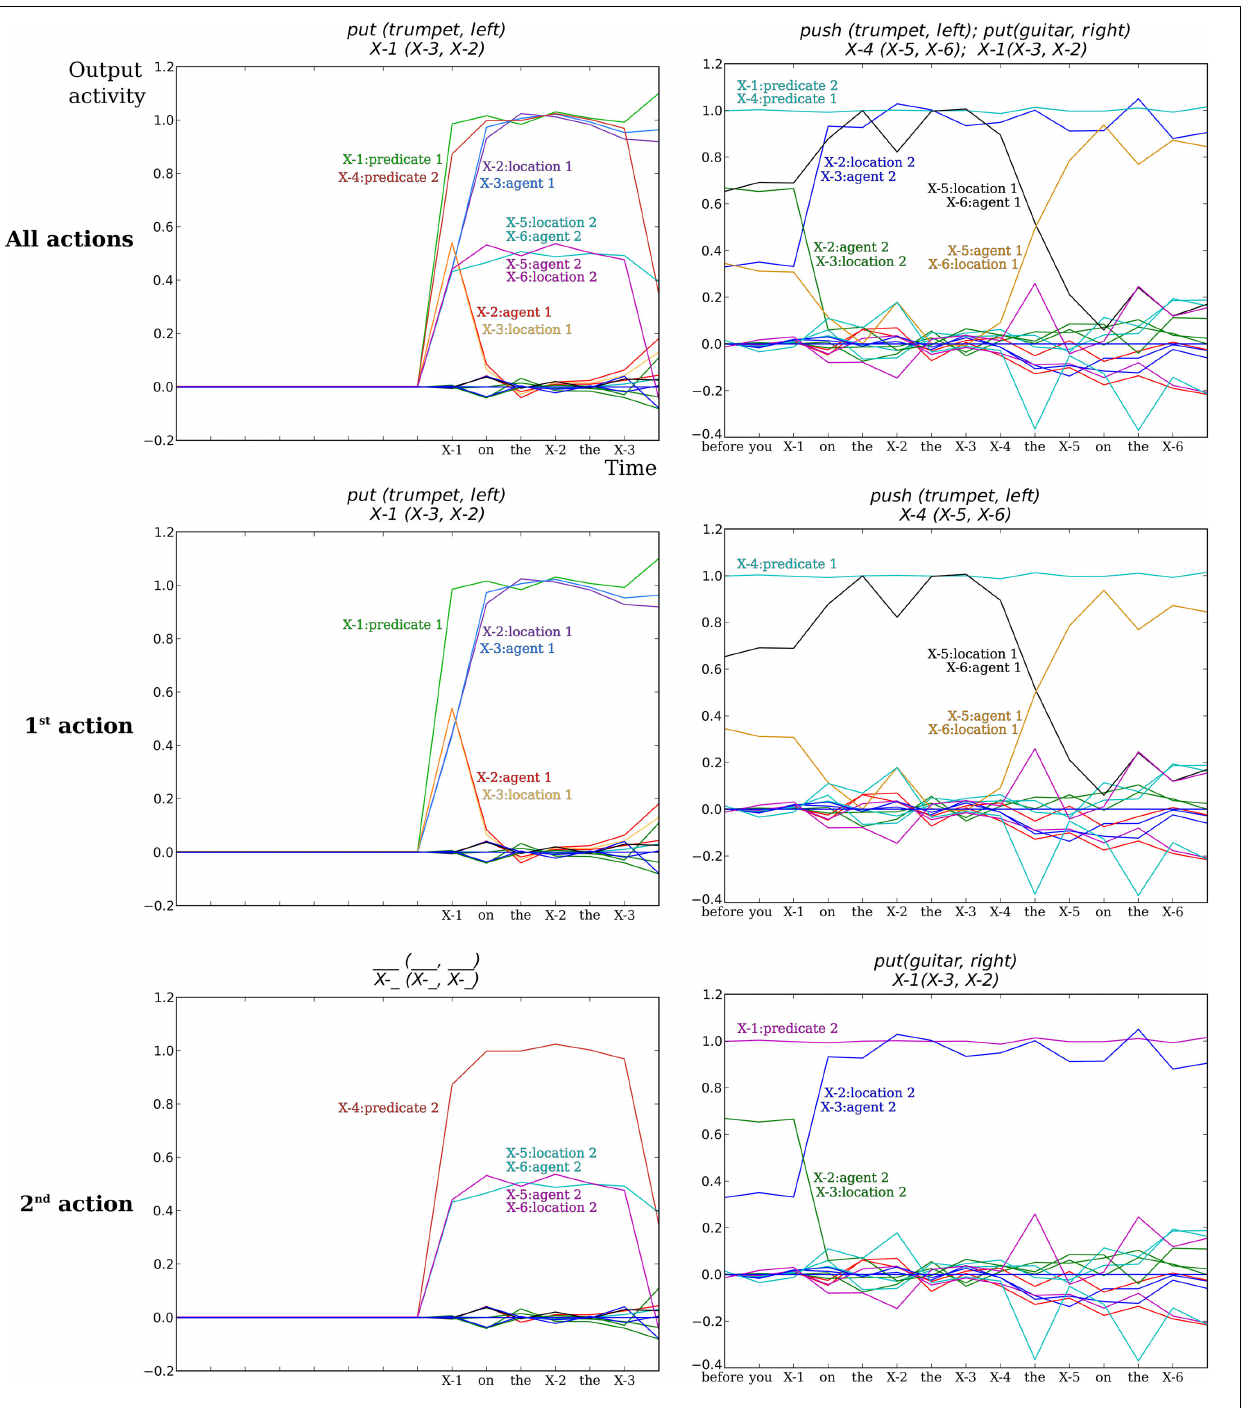
FIGURE 8 | Example of output activity of the comprehension neural model for the “Action Performing” task. Each colored line indicates the pseudo-probability for each semantic word to have a given role ( predicate , agent , location ) for each of the two specified actions. (Top row) Output activity for both actions. (Middle row) Output activity for the first action to perform. (Bottom row) Output activity for the second action to perform. (Left column) The input sentence was “put on the left the trumpet.” The model correctly determines that there is only one meaning-predicate put (trumpet,